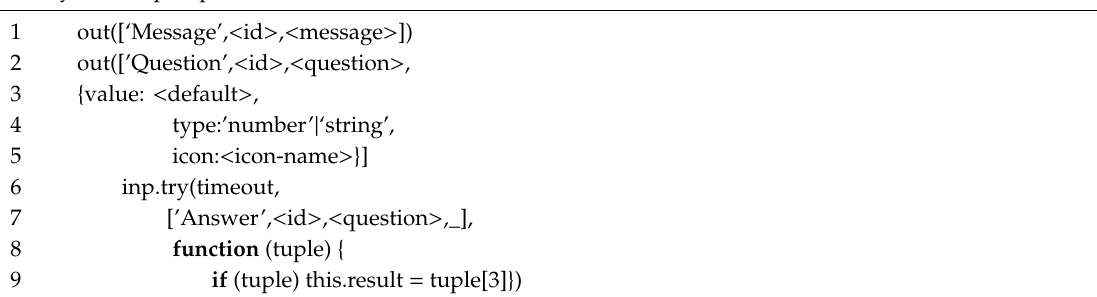
Algorithm 1: Communication of remote chat bot agents with user dialogue mediator agents via an anonymous tuple space